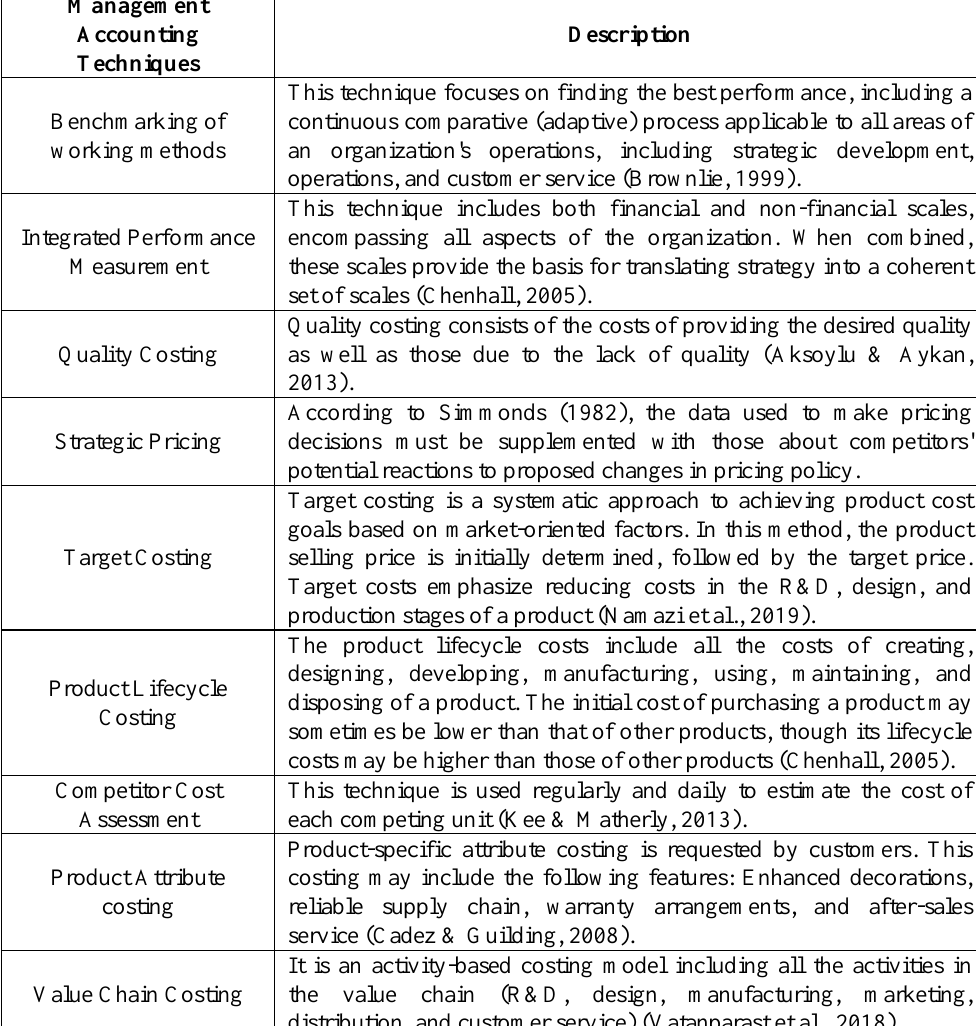
Table 2. Definitions of identified strategic management accounting